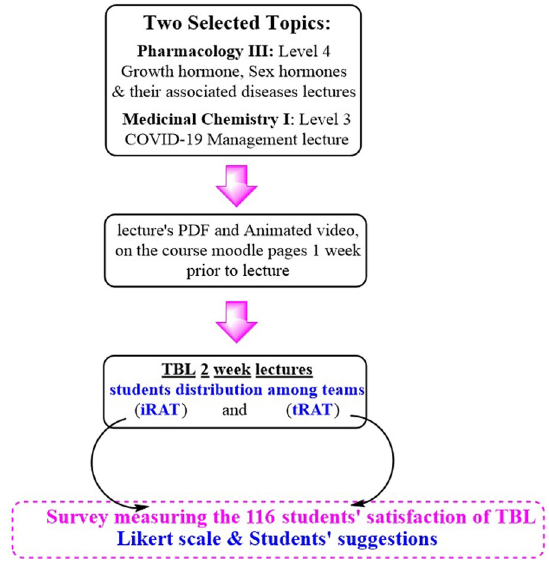
Fig. 1 A schematic representation of methodology design for TBL